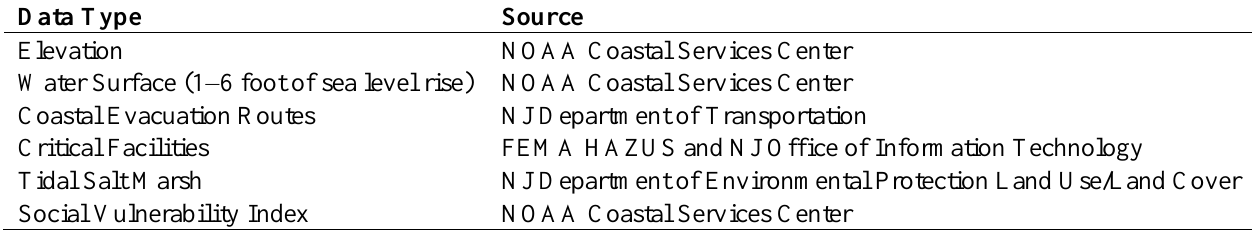
Table 2. Summary of the geographic information systems (GIS) data employed in NJFloodMapper